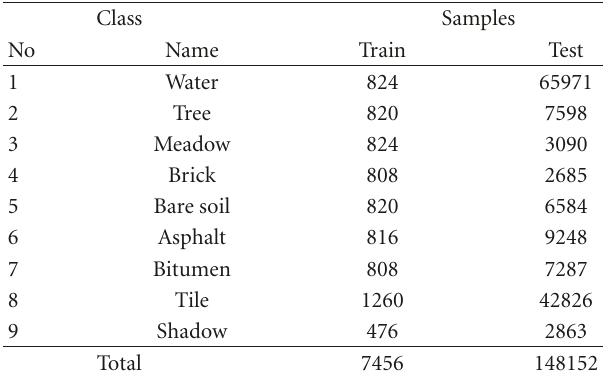
Table 2: Information classes and training/test samples for the Pavia Center data set.